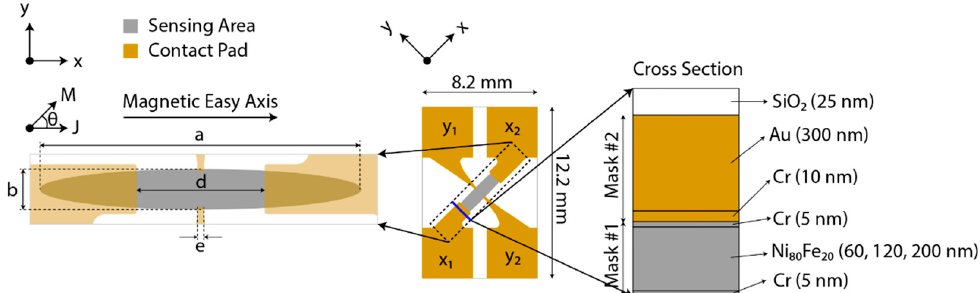
Figure 1. Geometry of the EPHE sensor with the layer composition. The current excitation node is x 1 and x 2 along the magnetic easy axis. The voltage measuring node is y 1 and y 2 . The exposed permalloy by the gold film defines the sensing area. Cr/Ni 80 Fe 20 /Cr was fabricated with photomask #1, and Cr/Au/Cr was fabricated with photomask #2. Table 1. Dimensions of the sensor variants based on the sensing